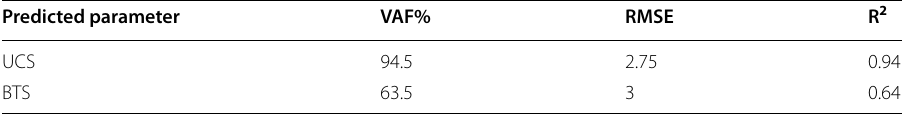
RMSE root mean square error, VAF % value account for and R 2